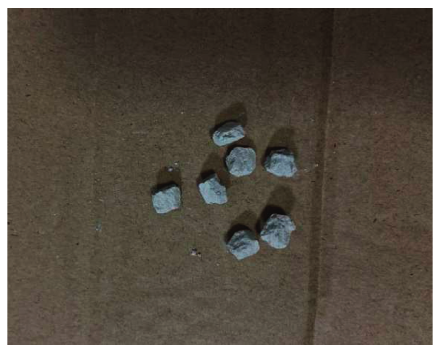
Figure 11: The samples prepared for the mercury intrusion test. Table 6: The evaluation criteria for the corrosion status of steel bars.